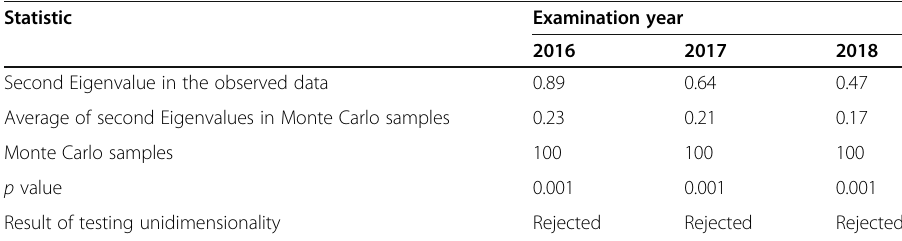
Table 1 Testing unidimensionality of the EFL reading comprehension tests using the unified parallel analysis